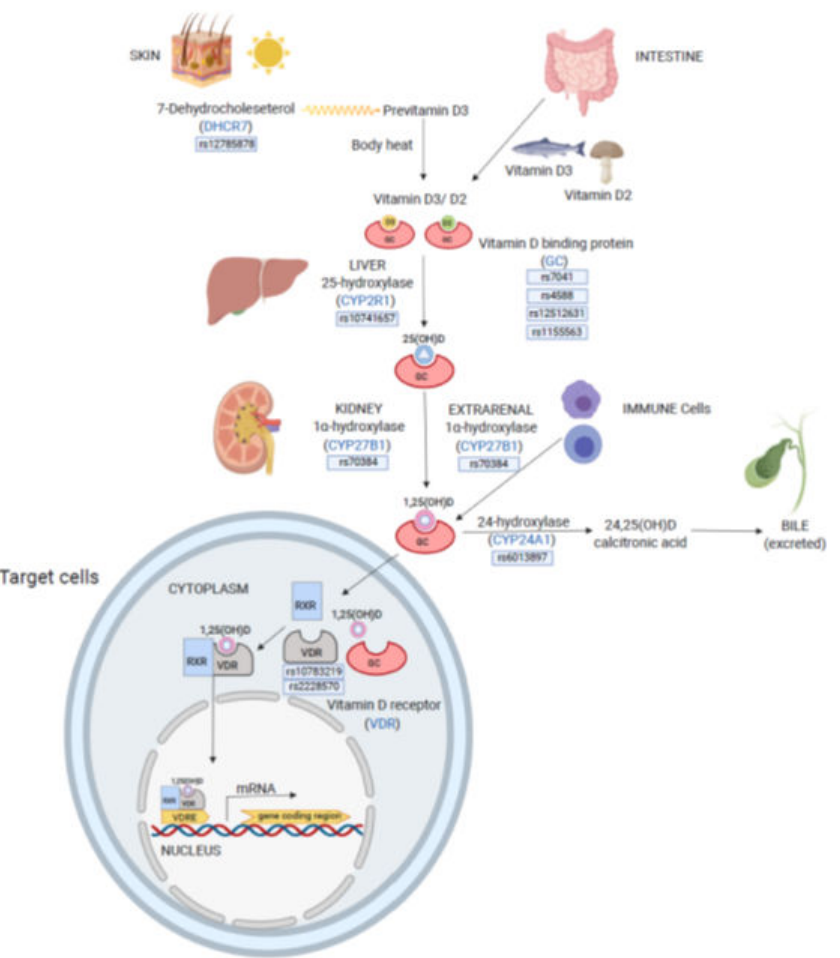
Figure 1. Selected genes related to vitamin D metabolism: Vitamin D (ergocalciferol (vitamin D2) and cholecalciferol (vitamin D3)) can be obtained from foods or endogen synthesis (vitamin D3) in the skin. During cholesterol synthesis, 7-Dehydrocholesterol is formed by the enzyme 7-dehydrocholesterolreductase (DHCR7) as an intermediate product that is converted to vitamin D3 on exposure to sunlight. Vitamin D2, D3 and their metabolites are transported into the blood